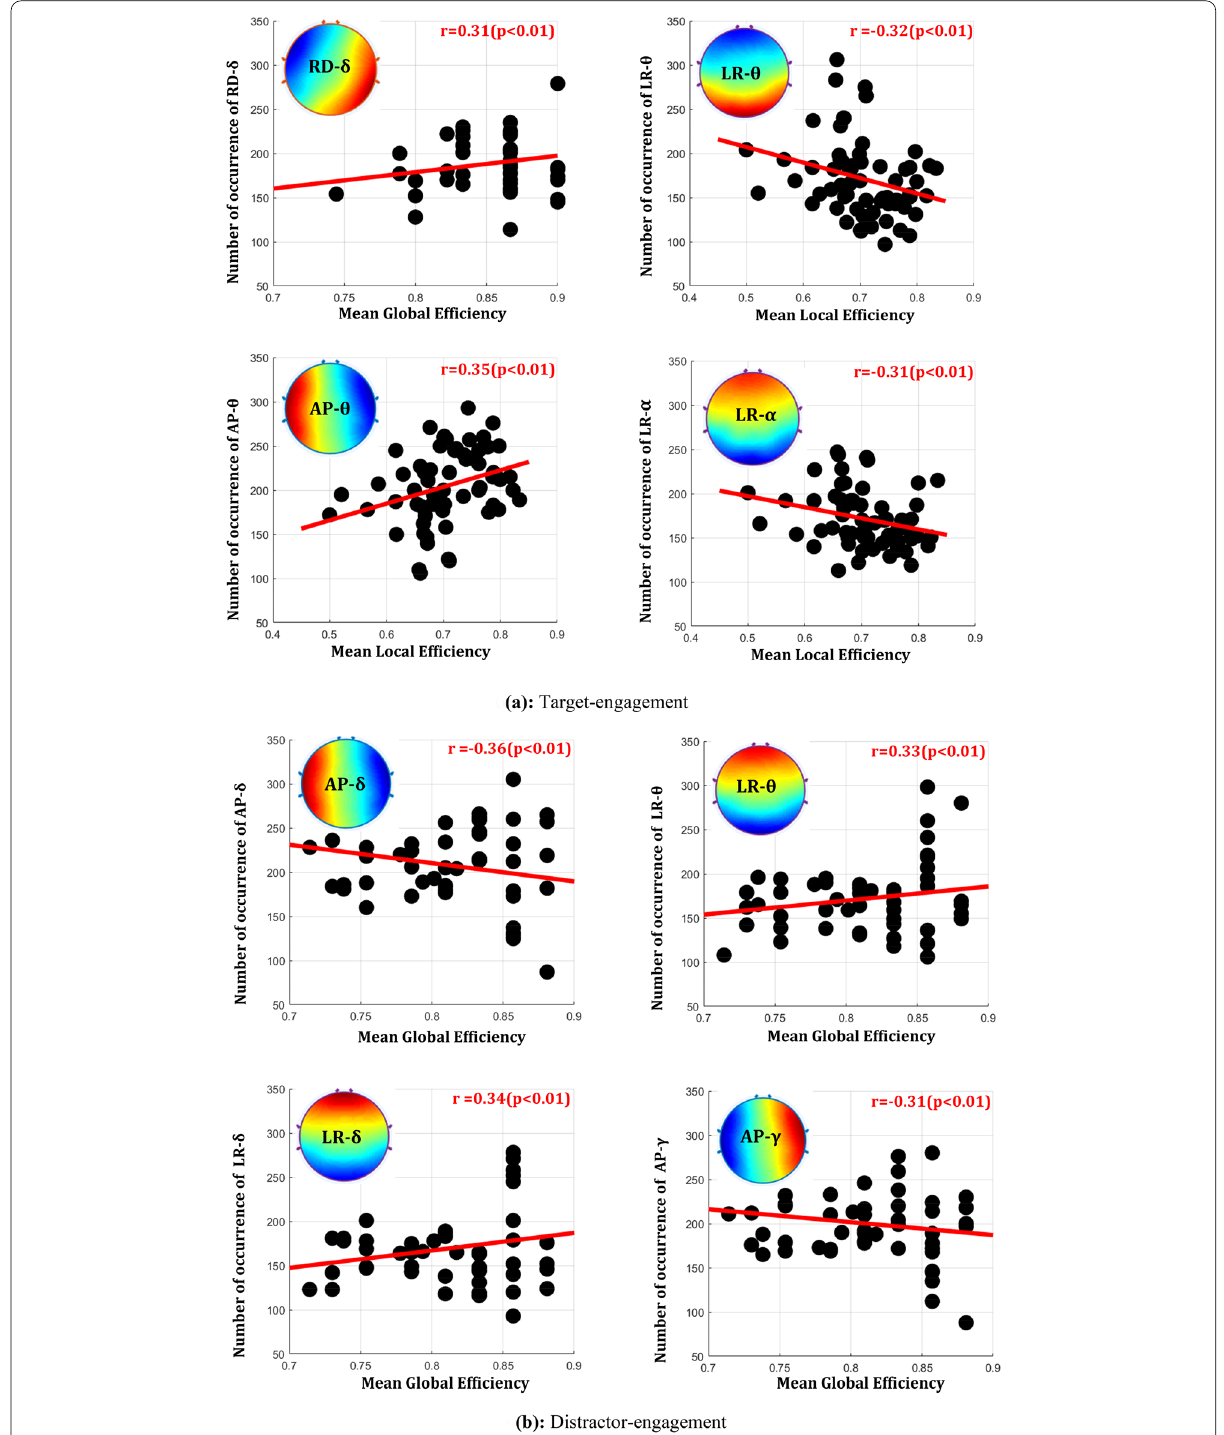
Fig. 6 Significantly associated, optimized, frequency-microstates with graph-theoretical measures of a target, b distractor, and c fixation task engagement. Frequency microstates are labeled as anterior–posterior (AP), left–right (LR), left diagonal (LD), and right diagonal